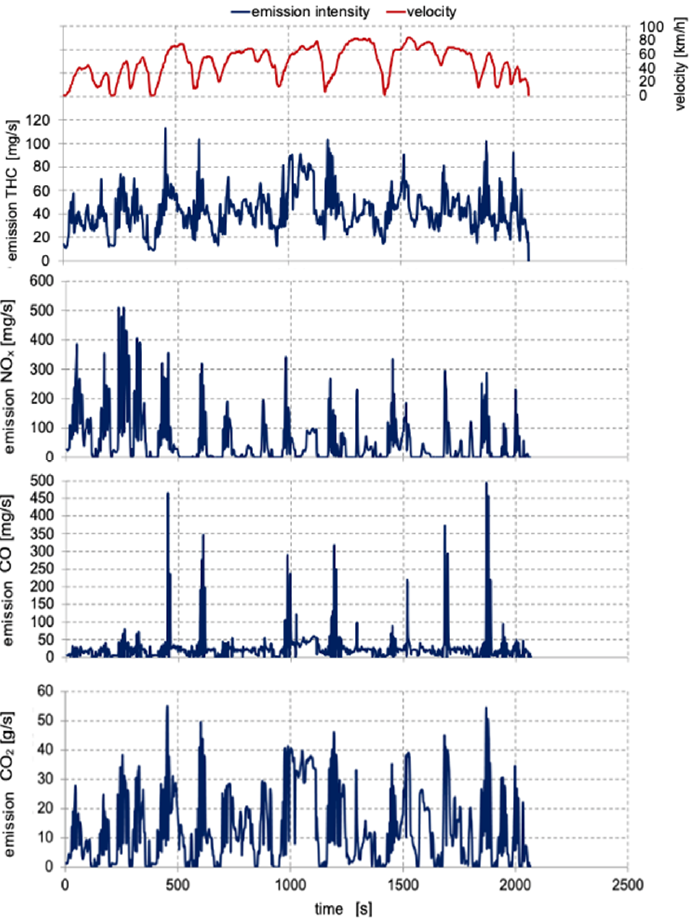
Figure 6. Tracings of the emission intensity of individual exhaust components during the test run the tractor-trailer under actual traffic conditions. of the tractor-trailer under actual traffic conditions.